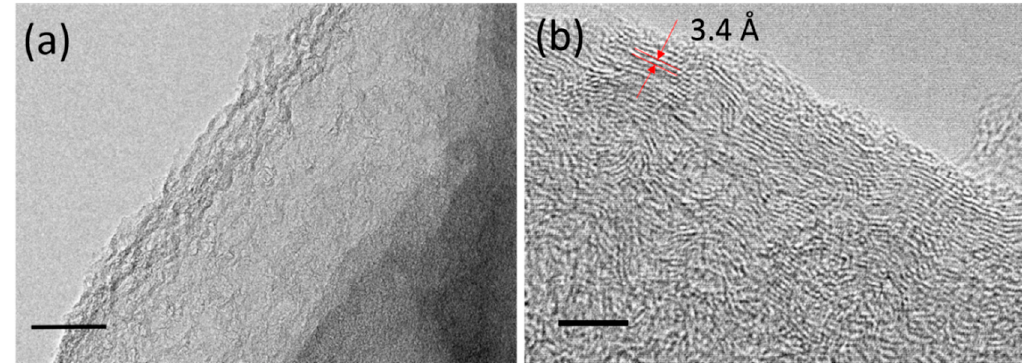
Figure 3. Low-resolution TEM image of the LIG, scale bar: 50 nm ( a ); high-resolution TEM (HRTEM) image taken at the edge of an LIG flake, scale bar: 5 nm ( b ).